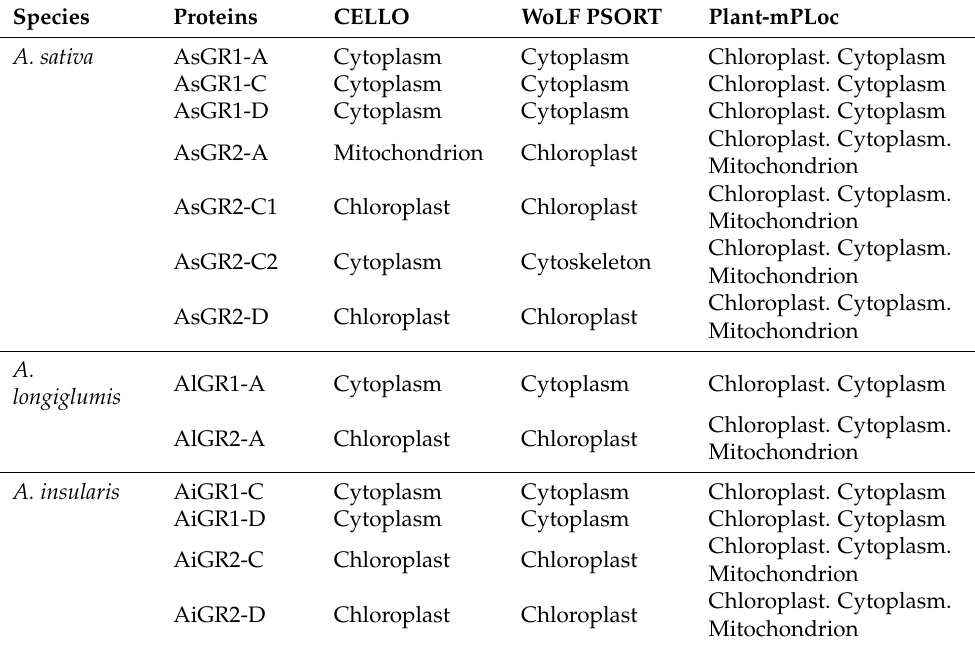
Figure 2. Phylogenetic relationships of GR proteins. The phylogenetic tree based on GR sequences from A. sativa (green) , A. longiglumis (purple), A. insularis (orange) Arabidopsis (red) , rice (blue), and bread wheat (turquoise) was constructed using MEGA v6 with the neighbor-joining (NJ) method, and the bootstrap test replicate was set as 10,000 times. Table 2. In silico subcellular localization prediction of GR proteins.